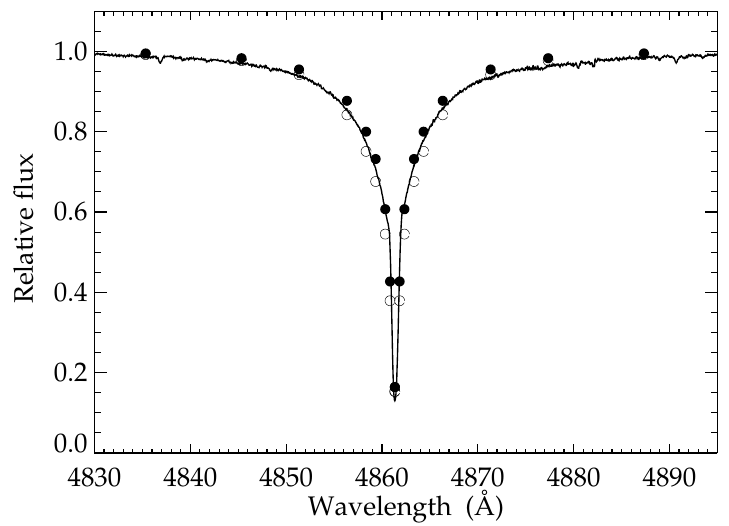
Fig. 1. The observed and calculated pro(cid:12)les of the H β line of HD 52961. The (cid:12)lled circles correspond to the model (6000/0.5), the open circles to the model